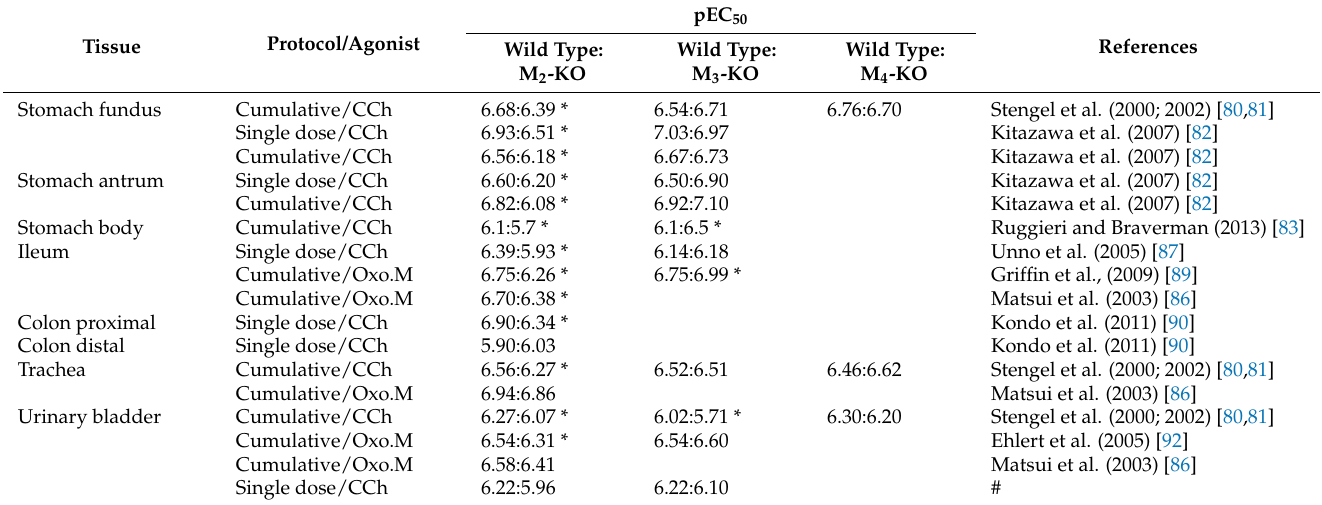
Table 2. pEC 50 values for muscarinic agonist-induced contraction of visceral smooth muscle from various mAChR-mutant